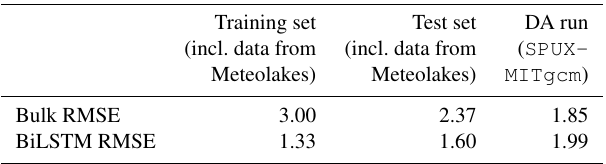
Table 4. Results of the BiLSTM model training (left two columns, with bulk temperature from Meteolakes; Baracchini et al., 2020b) and the performance in the DA run (right